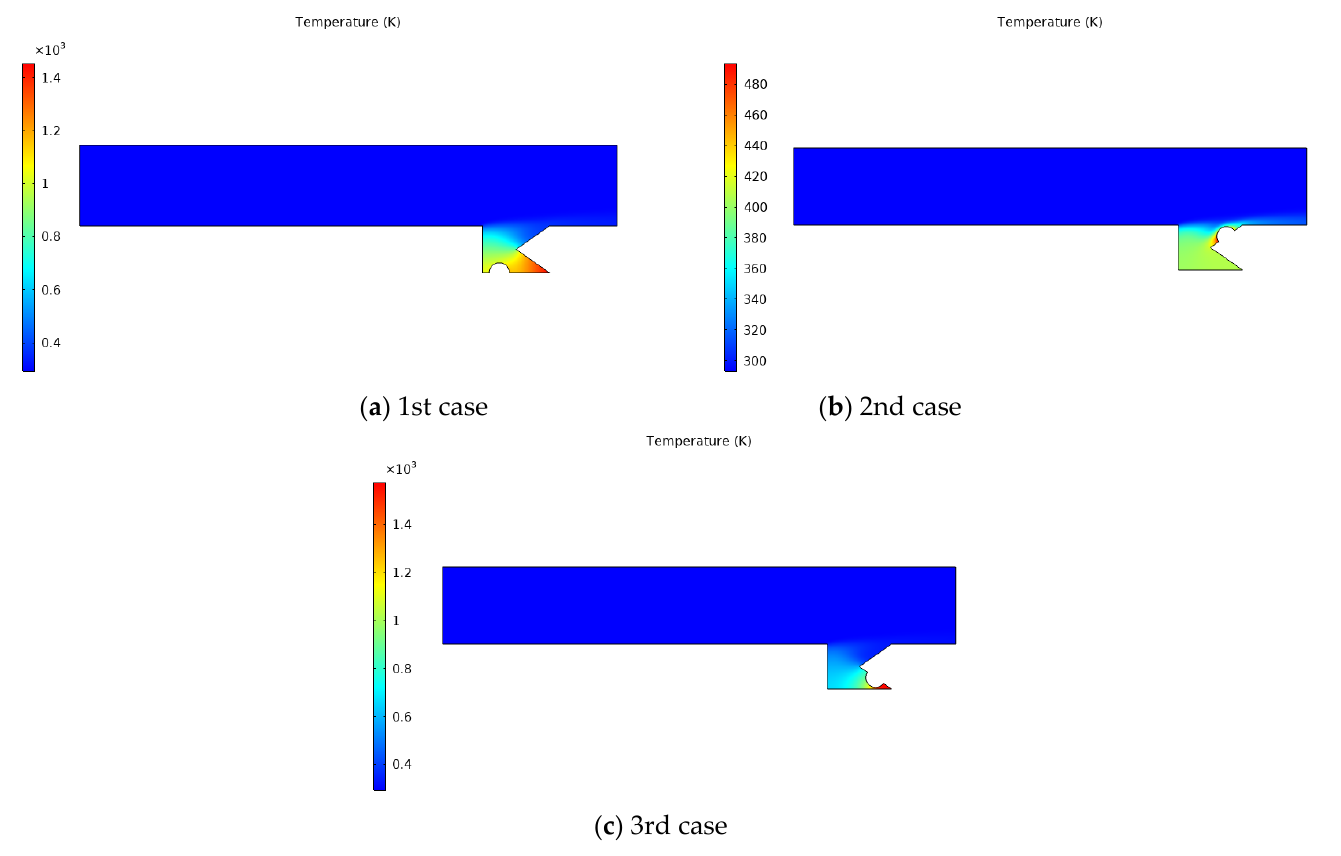
Figure 4. 2D passage temperature contours .